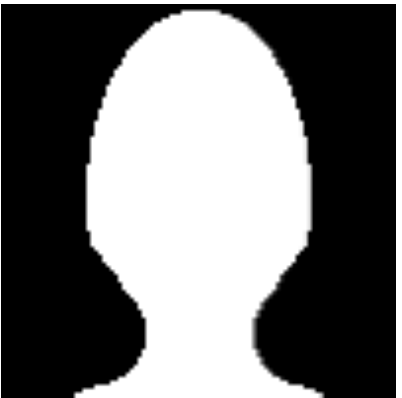
Figure 4. A generic binary shape containing head and neck region. This is the input template for the normalized